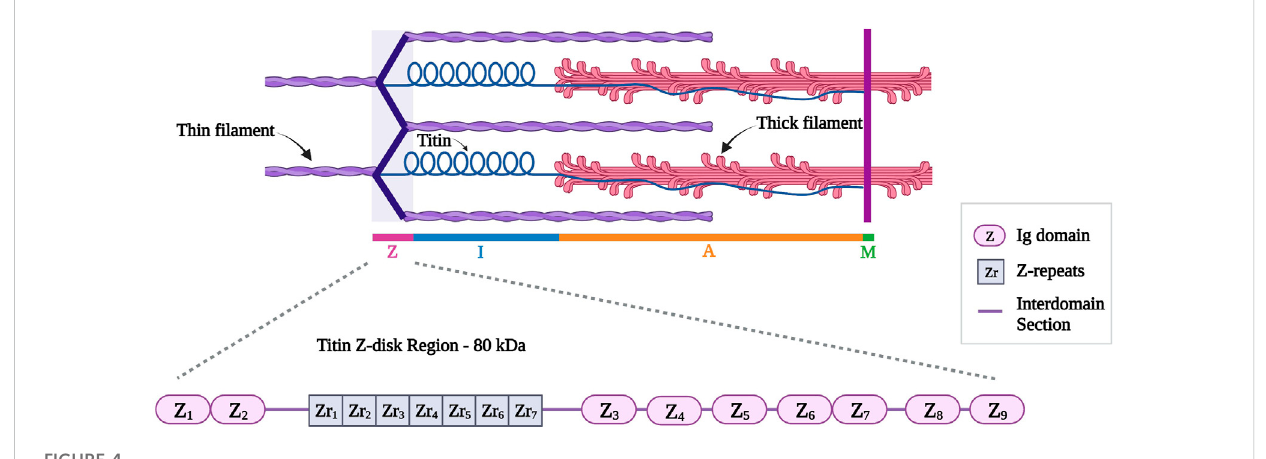
FIGURE 4 Schematic representation of titin (in blue) different regions with a detailed representation of titin Z-disk region with different Ig domains (Z1 to Z9) and Z-repeats (Zr1 to Zr7). Created with